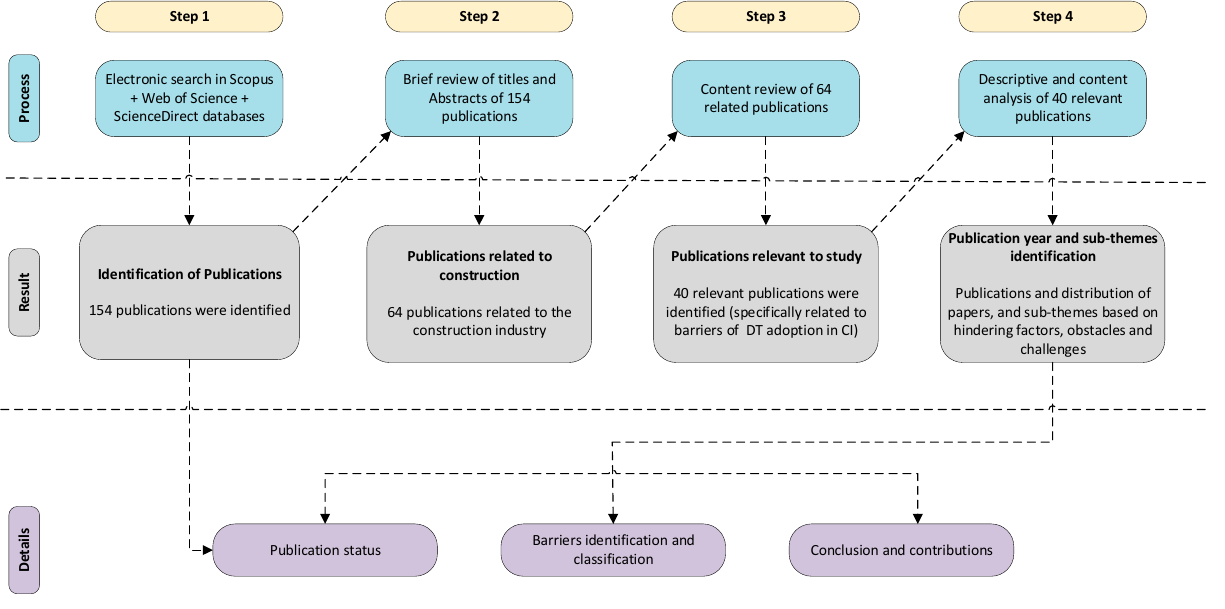
Figure 1. An overview of the literature review and research process adapted from Zhang and He [43] .